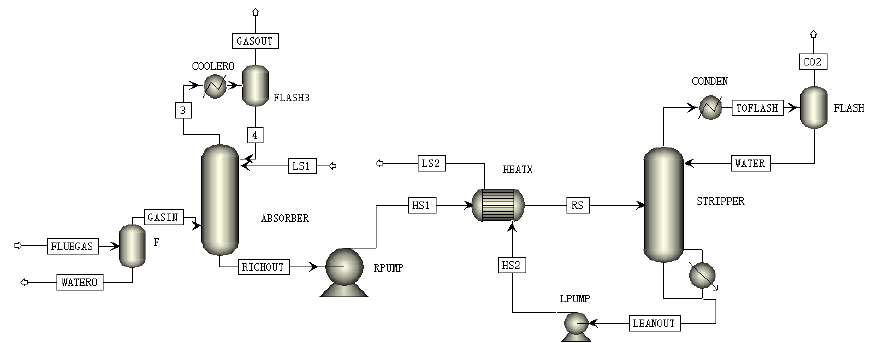
Figure 2. Schematic diagram of amine scrubbing process simulation.